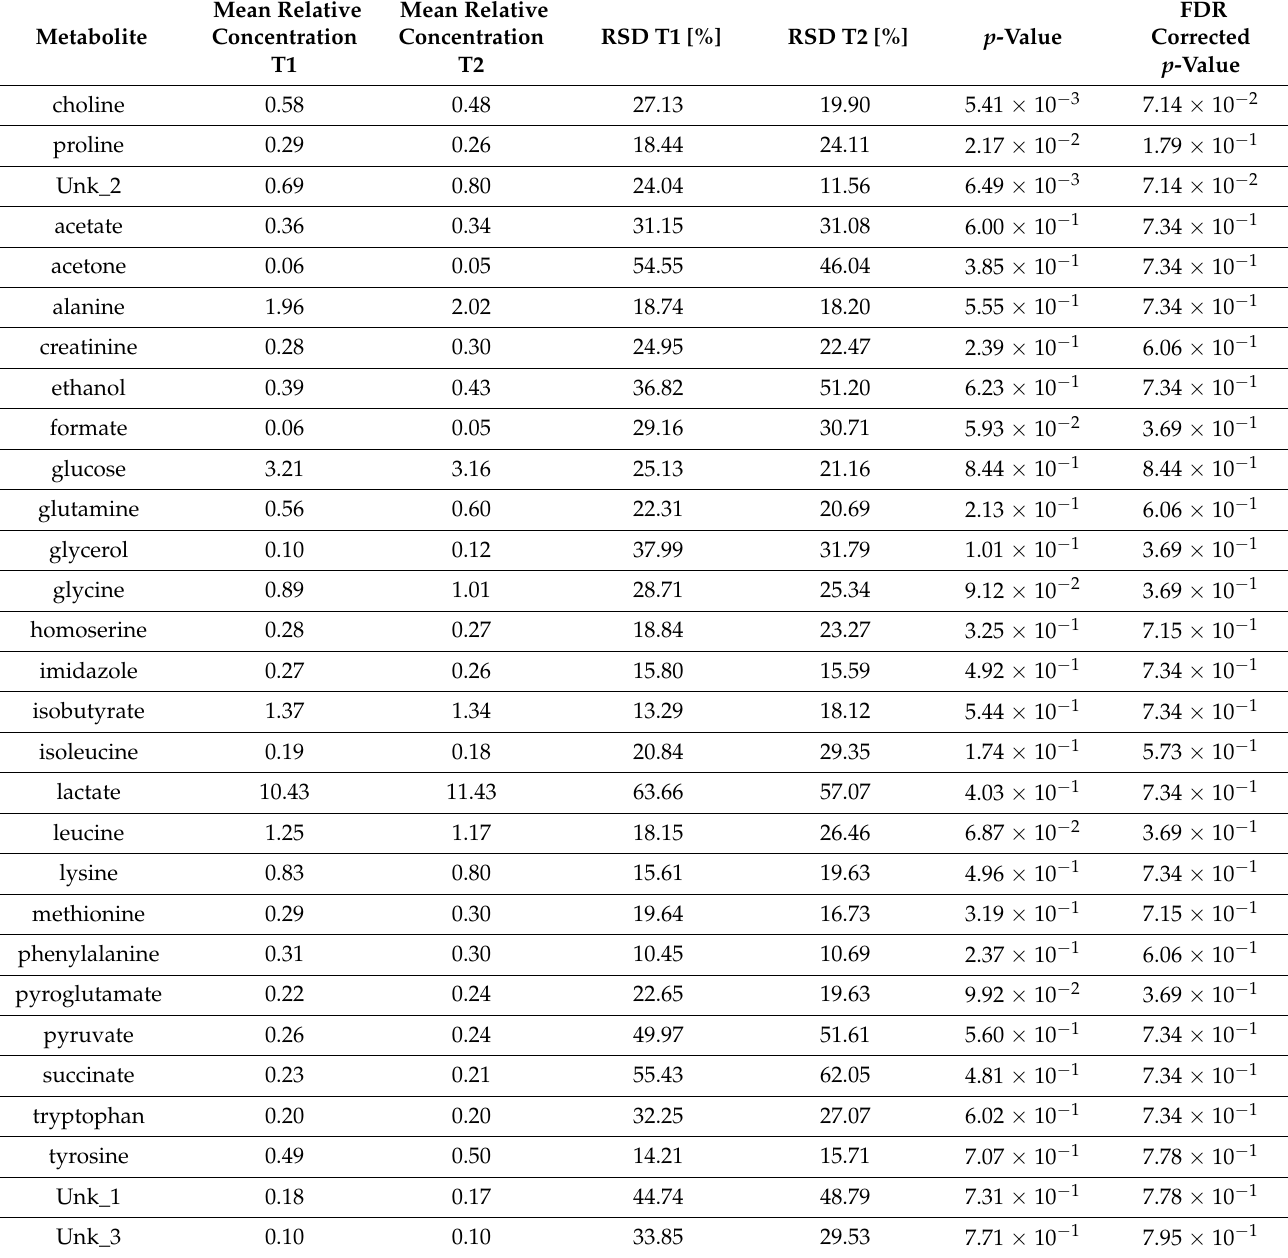
Table 3. Summary statistical analysis—comparison at Timepoints 1 and